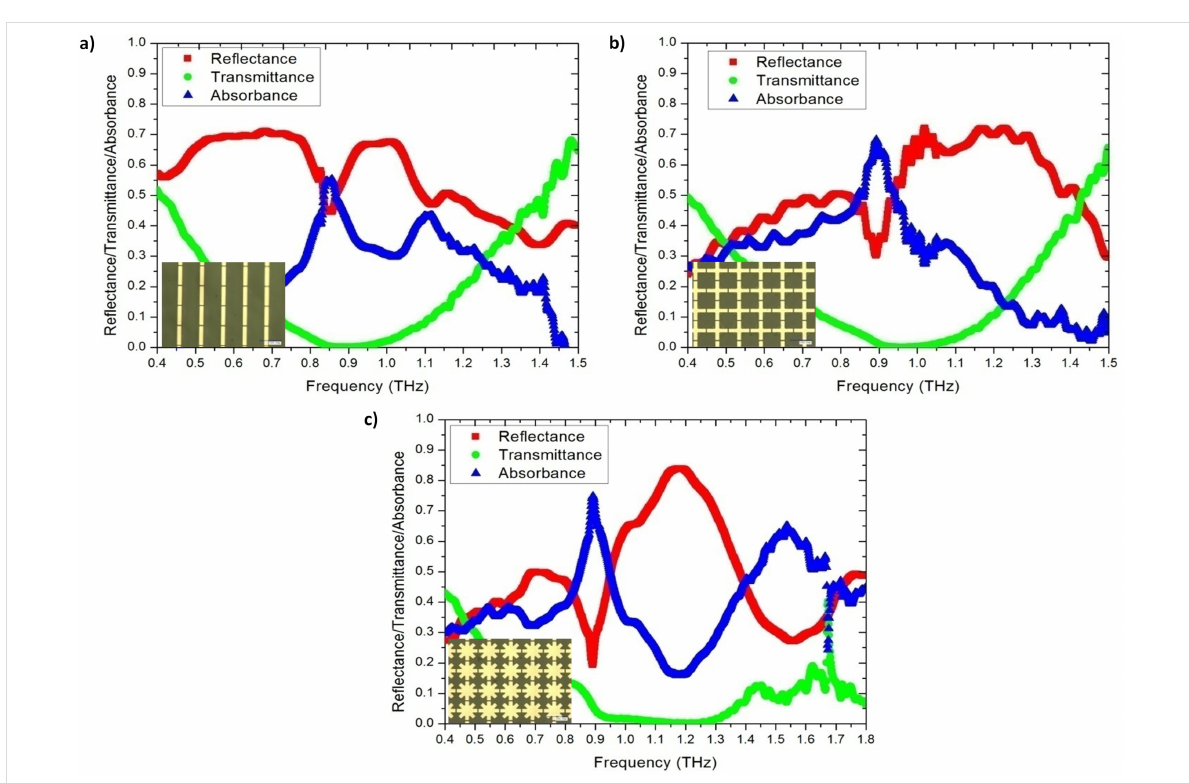
Figure 8: The measured results of reflectance, transmittance and absorbance under normal incidence: a) Cut-wire sandwich structure, b) cross- shaped sandwich structure, and c) star-shaped sandwich